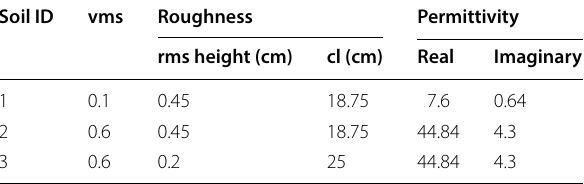
Table 4 Three kinds of soils with different surface roughness (rms height and cl) and soil moisture (vms)